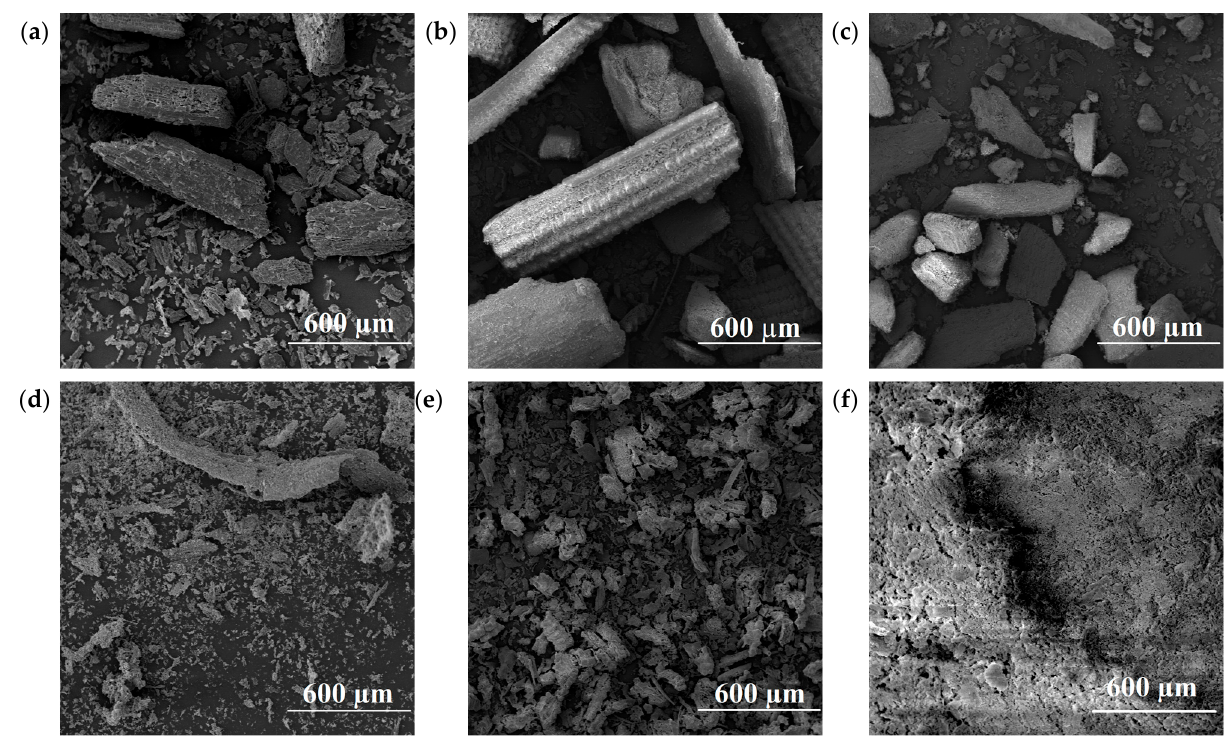
Figure 3. Structure of SH ( a ), RH ( b ), BH ( c ), SHA ( d ), RHA ( e ) and BHA ( f ).